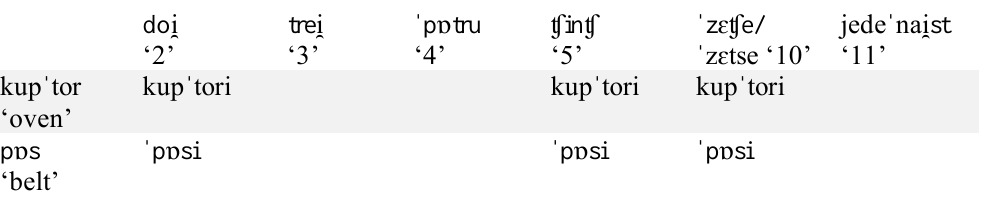
Table10. Unitary behaviour of some masculine nouns taking -i